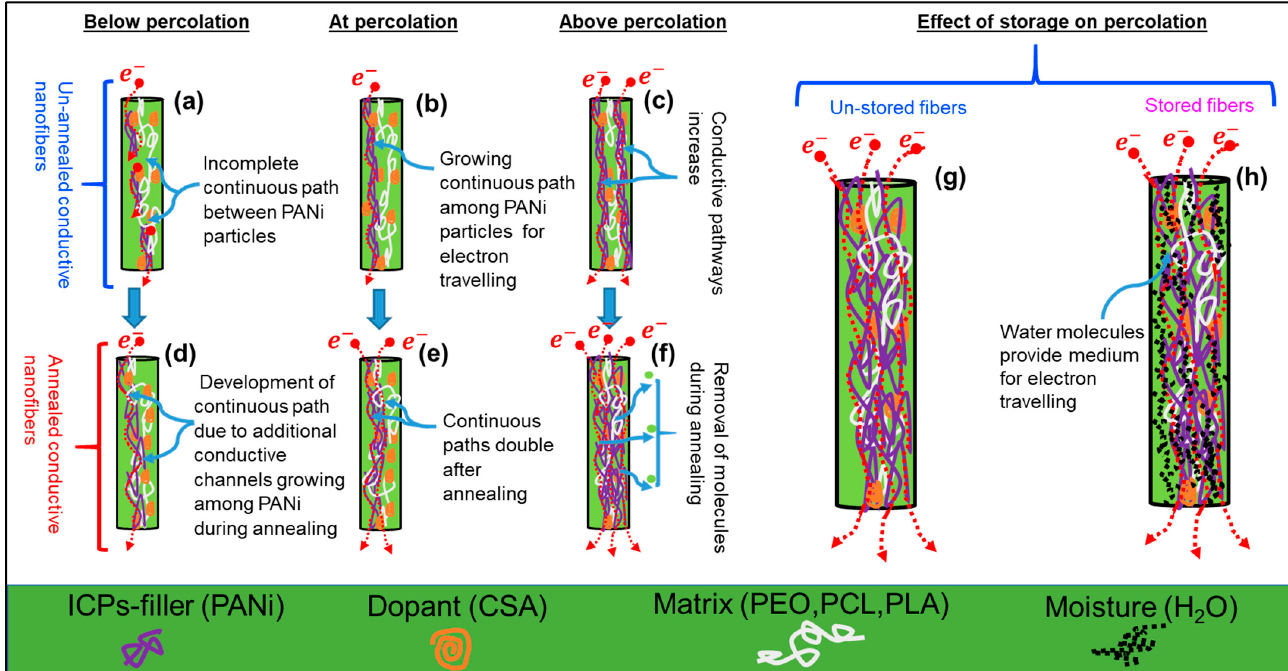
Figure 5. Schematic representation of percolation phenomenon within electrospun conductive nanofibers with and without annealing. Panel ( a ) elaborates the incomplete continuous path between PANi particles (below the critical concentration/percolation threshold). Panel ( b ) shows the completion of continuous path between ICPs particles for percolation phenomenon (at percolation threshold). Panel ( c ) shows that continuous pathways increase with increasing filler concentration. Panel ( d ) shows the development of continuous path due to generation of additional conductive channels among PANi particles during annealing. Panel ( e ) shows continuous paths doubling after annealing. Panel ( f ) shows continuous paths doubling due to physical/chemical interactions among PANi, CSA and PEO/PCL/PLA species with or without the removal of molecules at higher annealing temperature (above 100 ° C). Panels ( g , h ) show the freshly prepared (un-stored) and stored (storage at room temperature for 24 h) conductive fibers. In stored conductive fibers, the water molecules provide a medium between PANi particles for electron travelling.